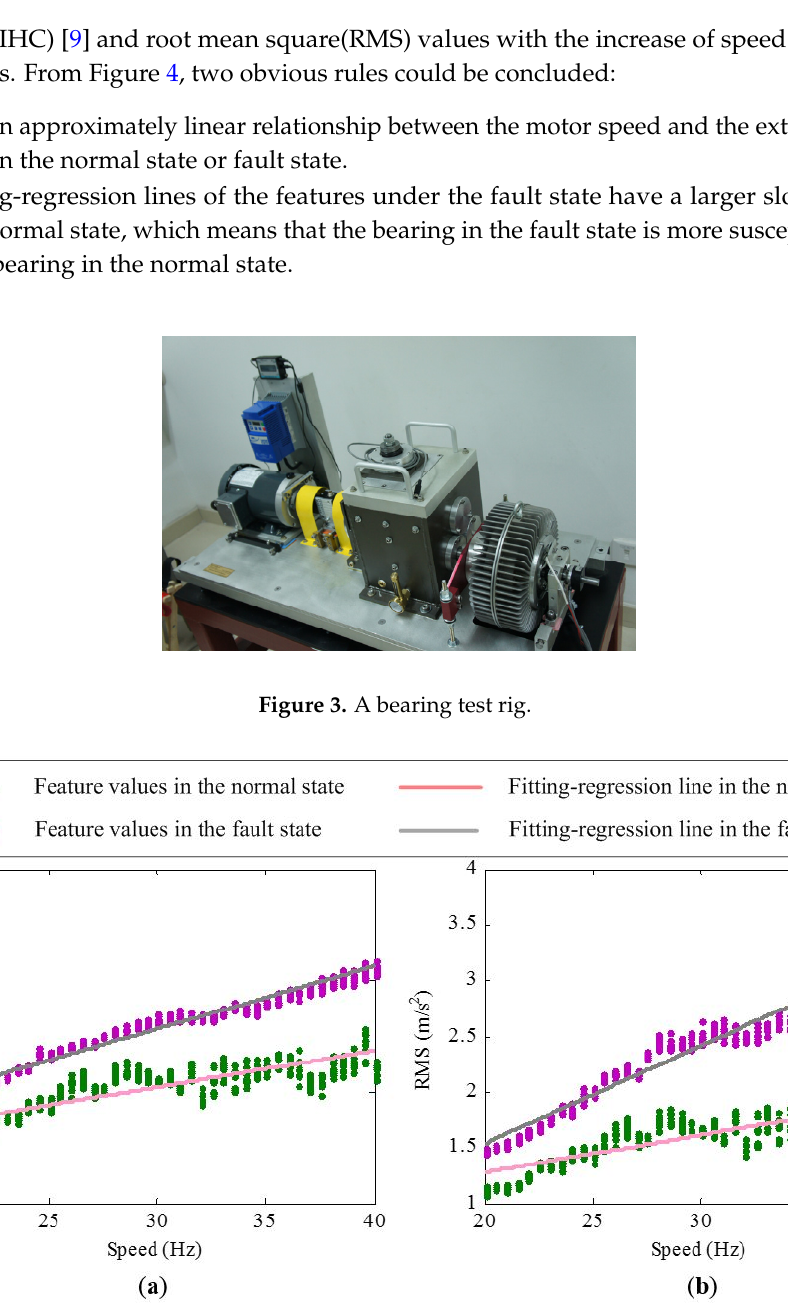
Figure 5. Schematic of RR feature extraction. Step 1: The speed condition parameters in the normal state (cid:1856) (cid:3047) ∈ (cid:1844) (cid:3003)×(cid:2869) is used as the input of the trained model and the dimensional feature in the normal state (cid:1832) (cid:3047) ∈ (cid:1844) (cid:3003)×(cid:2869) is utilized as the output of the trained model to train the ELM empirical model of the normal behavior, where B is the number of training samples. Step 2: The new captured operating speed (cid:1856)((cid:1872)) is used as the input of the trained model. The ELM model estimation output value of (cid:1856)((cid:1872)) can be obtained as (cid:1877)(cid:3548) = (cid:1858)((cid:1856)) .